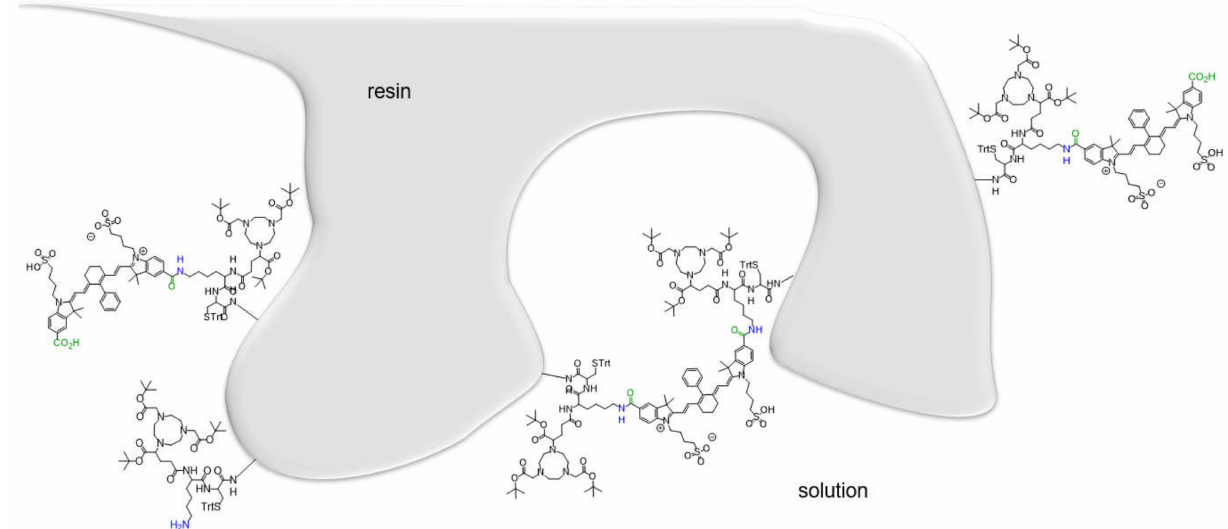
Figure 2. Schematic depiction of the assumed reason for the observed double reaction of 1 , giving both MIUs 2 and 3 in the same reaction step. In positions with only one isolated functional reactive amino group on the resin (blue), 2 is formed as the product (left and right), whereas in positions with two amino groups in the direct vicinity, a twice-activated dye can react on both ends (reactive carboxyl groups are depicted in green), resulting in 3 after cleavage and deprotection